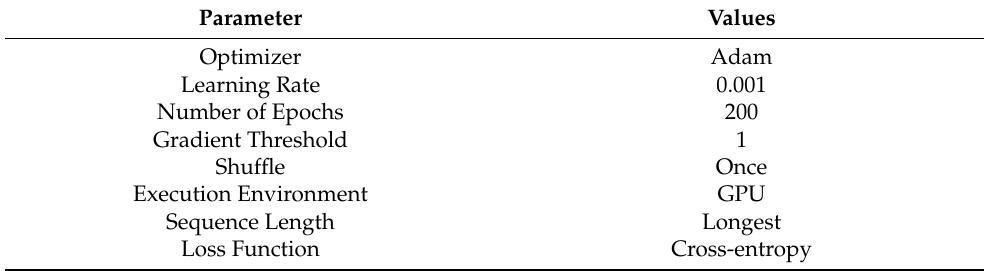
Table 1. The training options and the hyperparameters’